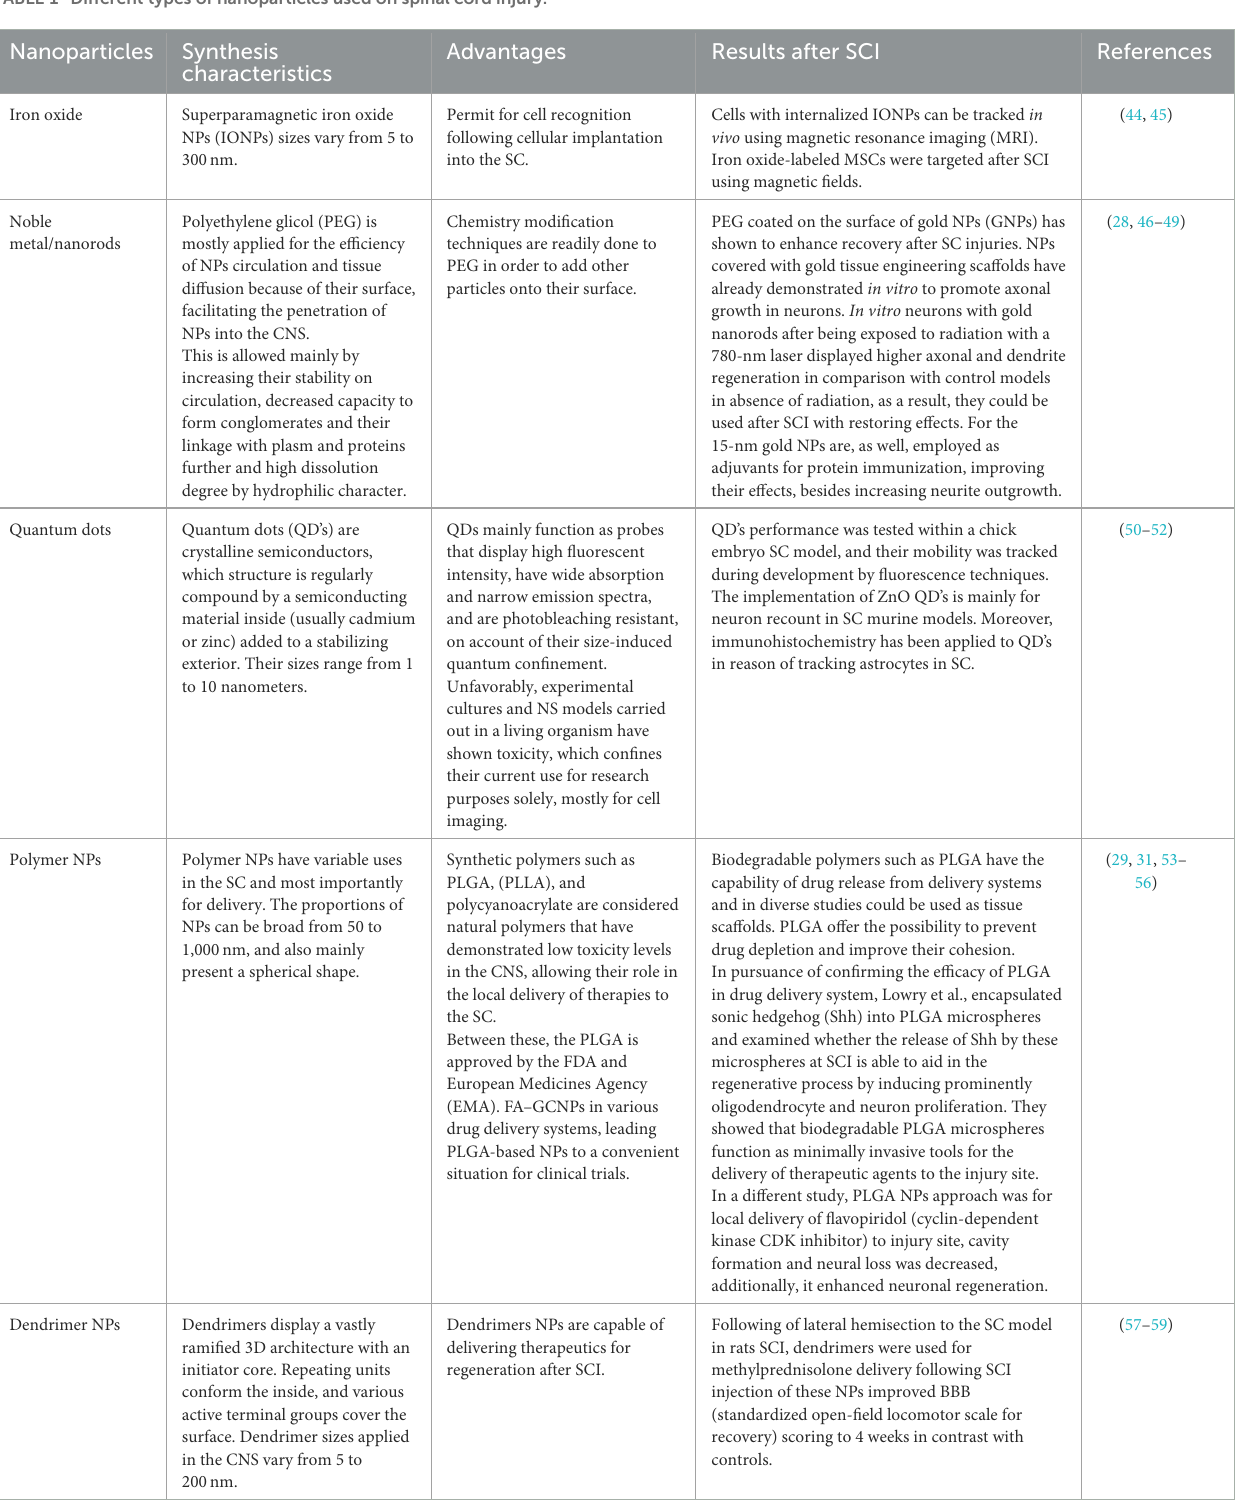
TABLE 1 Different types of nanoparticles used on spinal cord